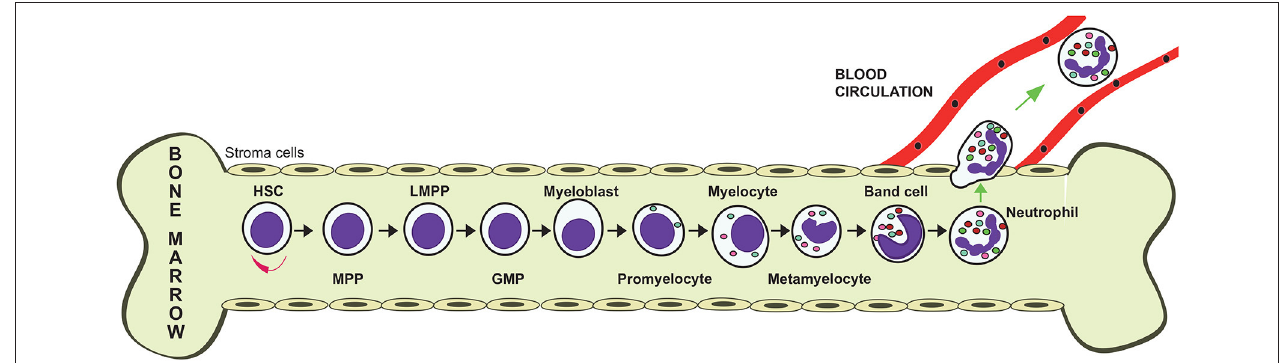
FIGURE 2 | Granulopoiesis. Neutrophils are produced in the bone marrow. From a self-renewing hematopoietic stem cell (HSC), a multipotent progenitor (MPP) cell is formed. MPPs give rise to lymphoid-primed multipotent progenitors (LPMP), which differentiate into granulocyte-monocyte progenitors (GMP). These GMPs, under control of the granulocyte colony-stimulating factor (G-CSF) commit to neutrophil generation by turning into myeloblasts, which then follow a maturation process that includes the stages of promyelocyte, myelocyte, metamyelocyte, band cell, and finally a mature neutrophil.